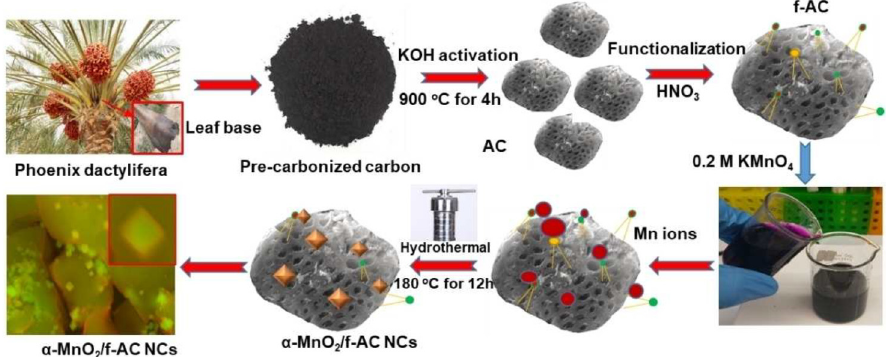
Figure 19. Procedures for immobilizing MnO 2 nanostructure on sustainable source-derived activated carbon. Reprinted from [43], ©2020 The Authors.